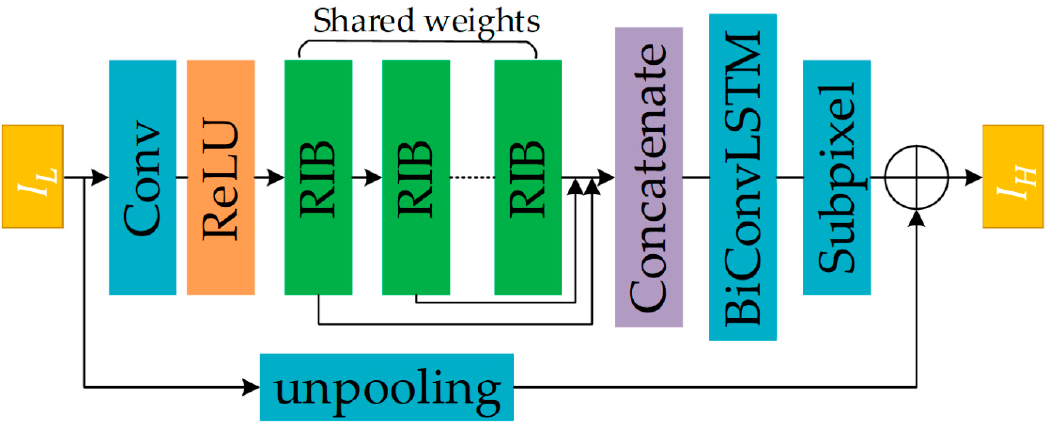
Figure 4. The architecture of our proposed model. The green box refers to the recursive inference